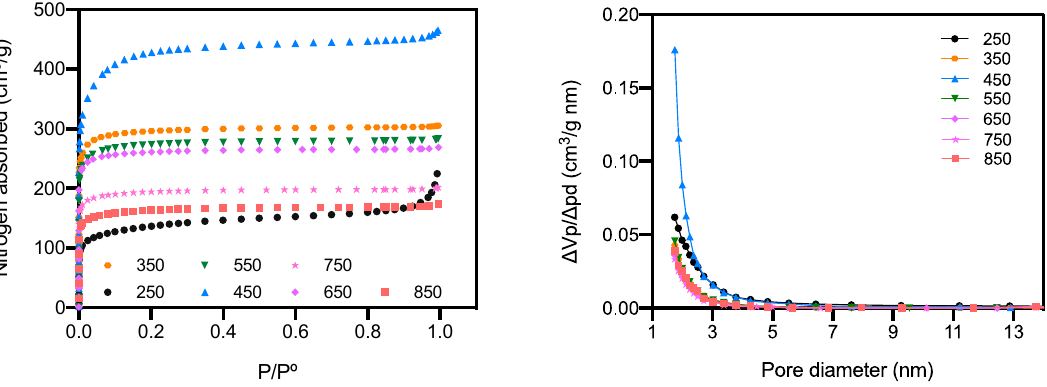
Figure 4. Nitrogen adsorption isotherms of activated biochars prepared at different temperatures.